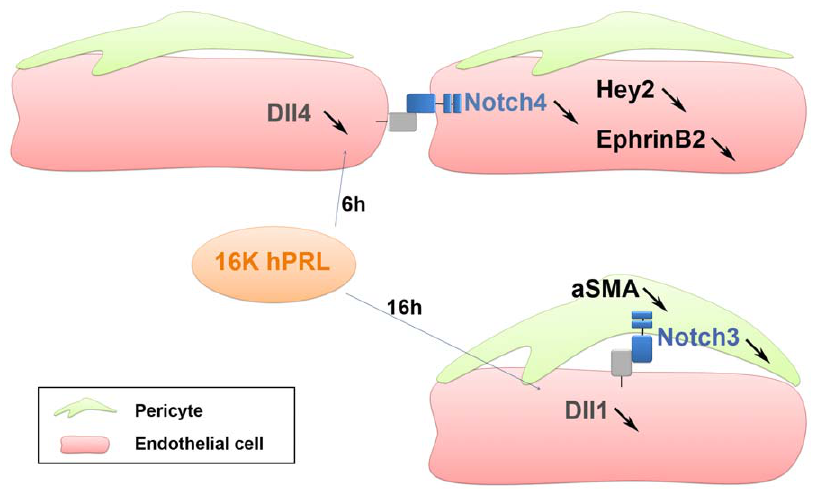
Figure 8. Hypothetical model of 16K hPRL effects on Notch signaling in endothelial/pericyte interactions. When endothelial cells are cultured with pericytes, Dll4/Notch4 pathway is activated. 16K hPRL treatment (6 h) alters Dll4/Notch4 signaling by decreasing DLL4 , NOTCH4 , HEY2 and EPHRINB2 transcripts in endothelial cells. After 16 h of endothelial cell-pericyte cocultures, Notch3 and Dll1 are increased respectively in pericytes and endothelial cells. 16K hPRL inhibits the Dll1/Notch3 signaling by reducing DLL1 transcripts in endothelial cells and NOTCH3 and aSMA transcripts in pericytes.